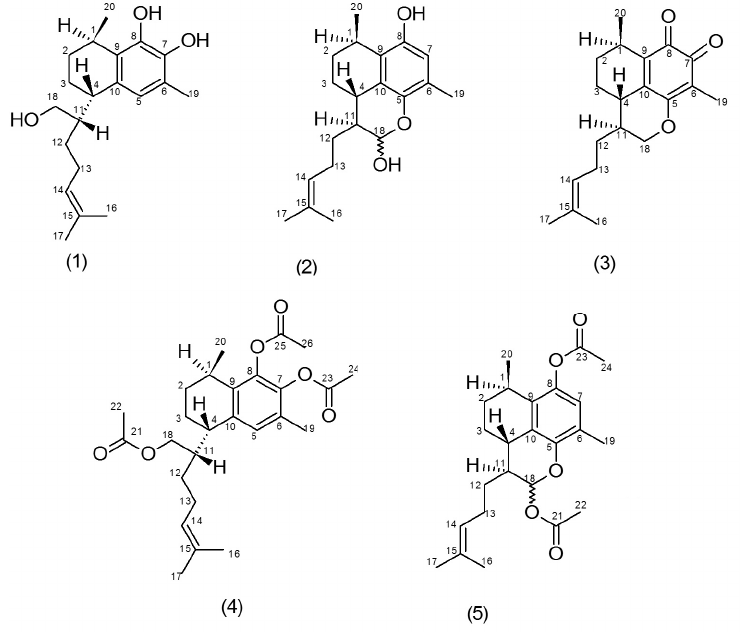
Figure 1. Chemical structures of the diterpenes, compounds 1–5 from the myoporum bee glue. Compound 1 was a yellow liquid identified as 7,8,18-trihydroxyserrulat-14-ene. Its molecular mass was recorded as m / z 341.2089 [M + Na] + (calcd. 341.2087) by HRESIMS analysis, hence